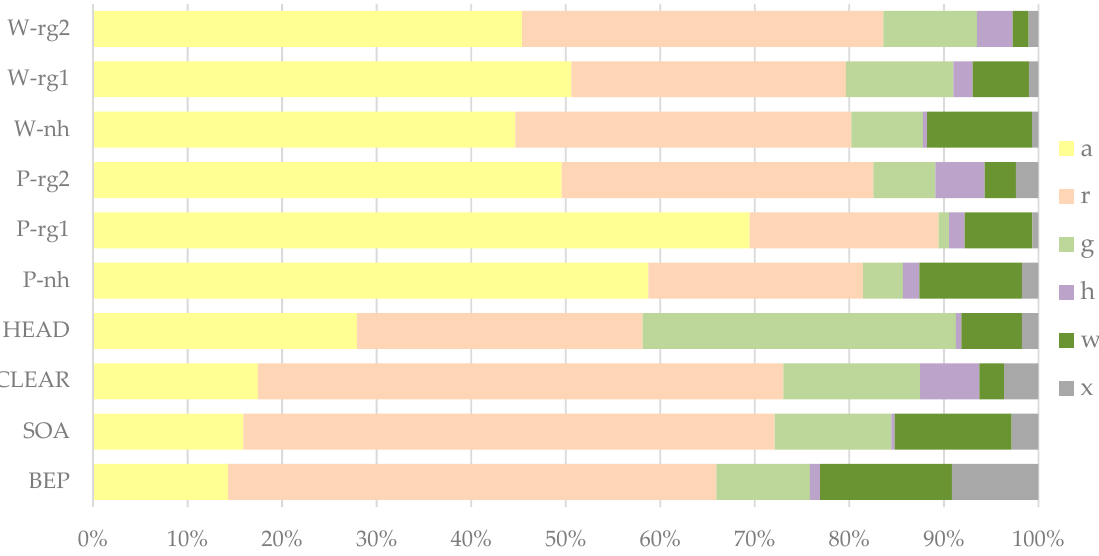
Figure 7. Proportions of plant species of different habitat preferences within the SRC stand types weighted with their frequencies (see Table 2 for abbreviations of stand types; different poplar (P) and willow (W) varieties are combined). Abbreviations for habitat preferences: a = species of arable land or short-lived ruderal habitats, r = species of persistent ruderal habitats, g = grassland species, h = species of heathland or nutrient-poor/dry grasslands, w = species of woodland, shrubs or hedges (incl. vegetation of woodland margins), x = indifferent, not stated or other habitat.